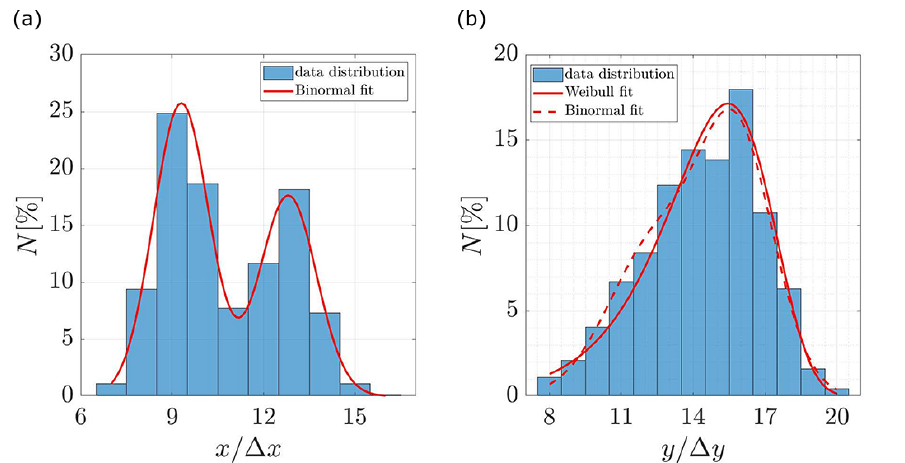
Figure 14. Probability distribution of the vortex center locations using the vorticity VIM and CD schemes. Additionally, red lines show fitting curves. (a) Streamwise direction. (b) Lateral direction.